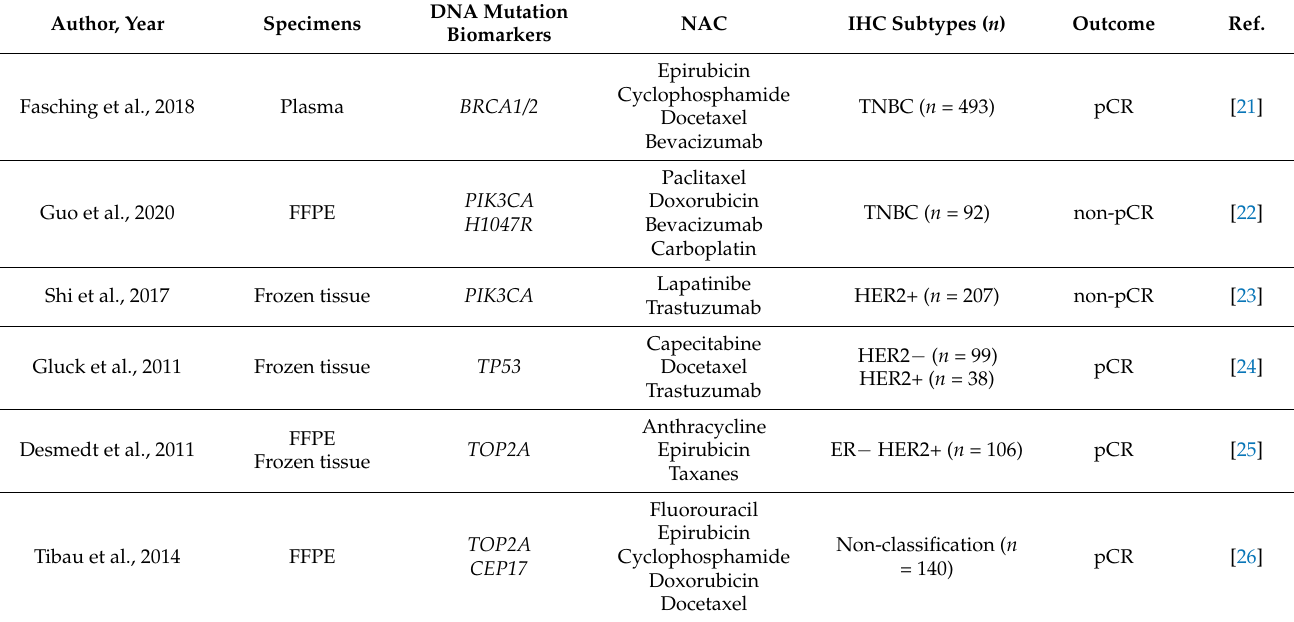
Table 1. DNA mutations as biomarkers of pCR or non-pCR after NAC in BC